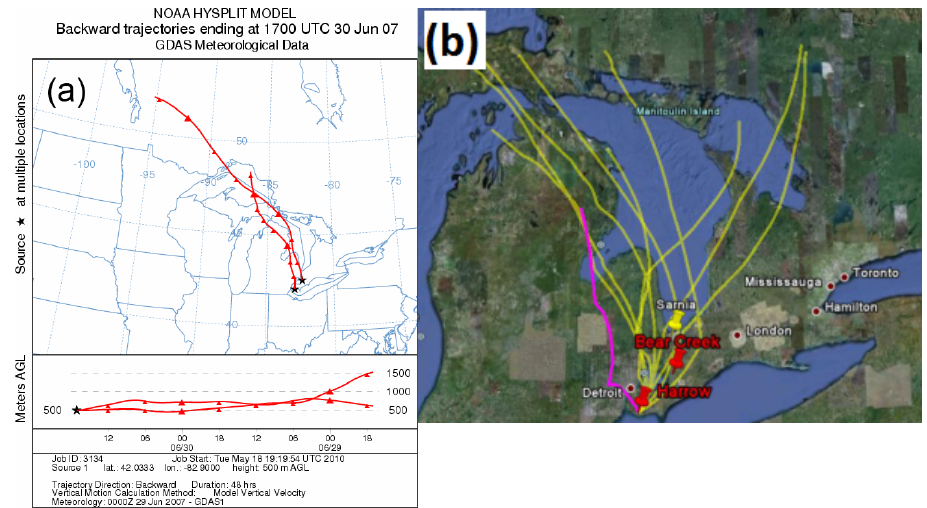
Fig. 4. Airmass sources during the Bear Creek-to-Harrow period (see Fig. 3, green period). Figure 4a shows HYSPLIT back trajectories to the Harrow and Bear Creek sites. Figure 4b shows high-resolution back trajectories to the Harrow site; the pink trajectory corresponds to the time period excluded from analysis (see